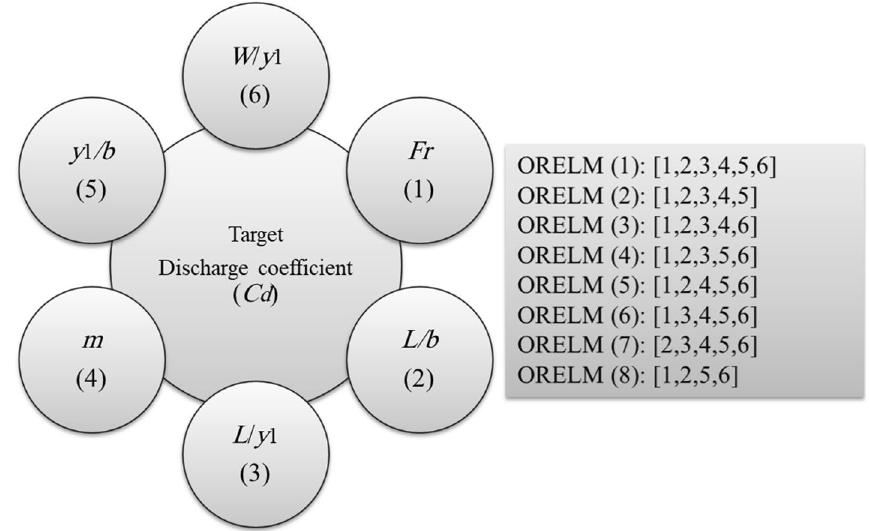
Fig. 1 Combinations of input parameters for developing ORELM